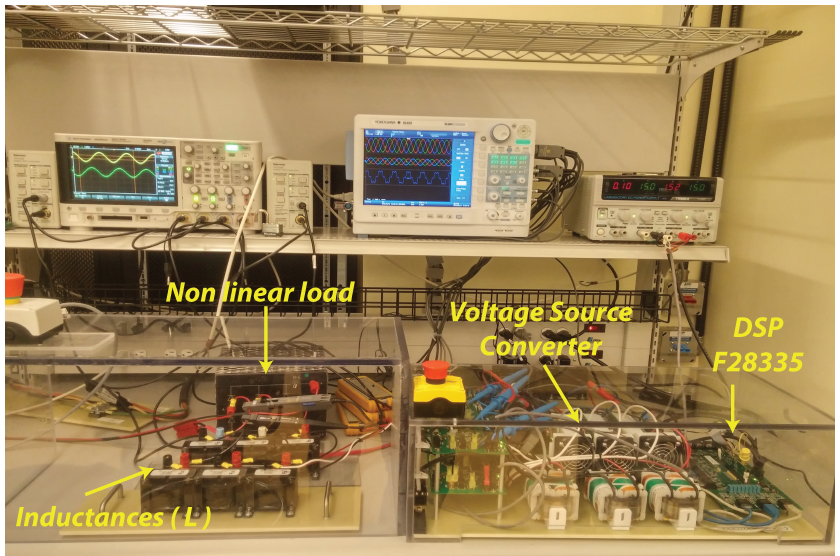
Figure 19. Laboratory setup used for the